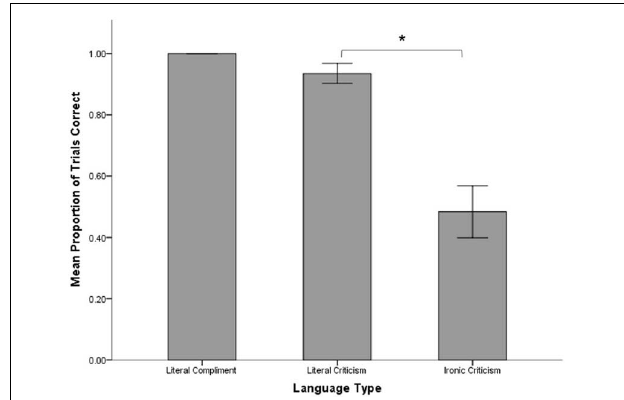
FIGURE 2 | Mean proportion of trials with correct speaker intent actions across all three language types. Bars represent standard error. Asterisk represents a significant difference in mean accuracy ( p < 0 .